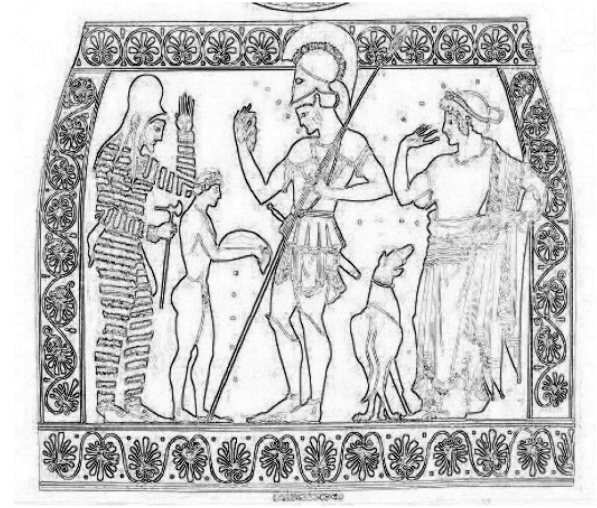
Figure 16. Wurzburg, Universität, Martin von Wagner Museum L507, Kleophrades, ca. 500. After (Furtwängler and Reichhold [1904] 1932, pl. 103; cf. also Mayor et al. 2014, fig. 13).